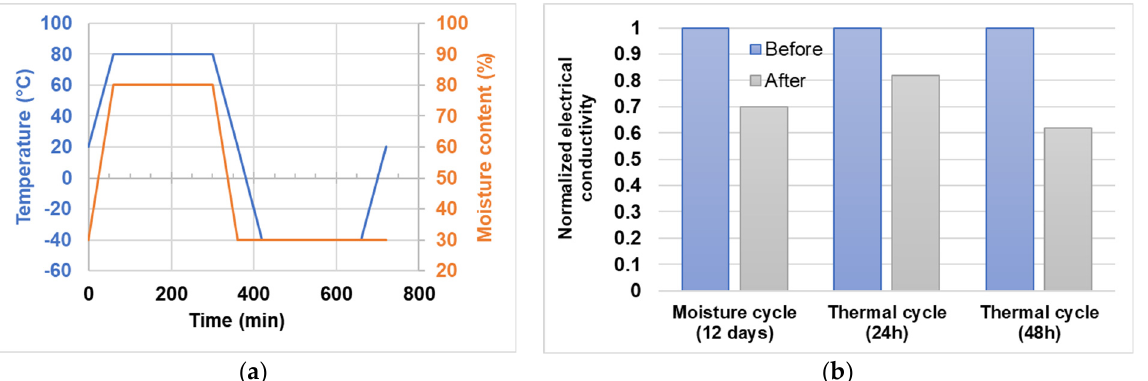
Figure 19. Aging test of the copper electrode coating: ( a ) pro fi le of temperature and moisture in one cycle and ( b ) evolution of the electrical conductivity (normalized value) before and after the temperature and moisture stability tests.